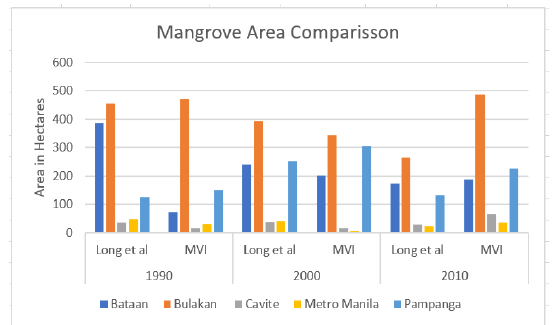
Figure 14. Mangrove Area